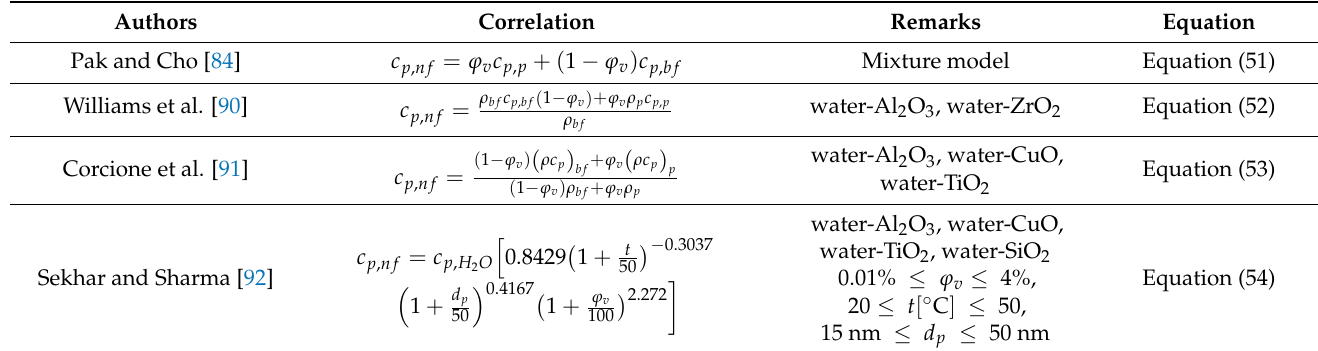
Table 10. Correlations for specific heat of nanofluids.